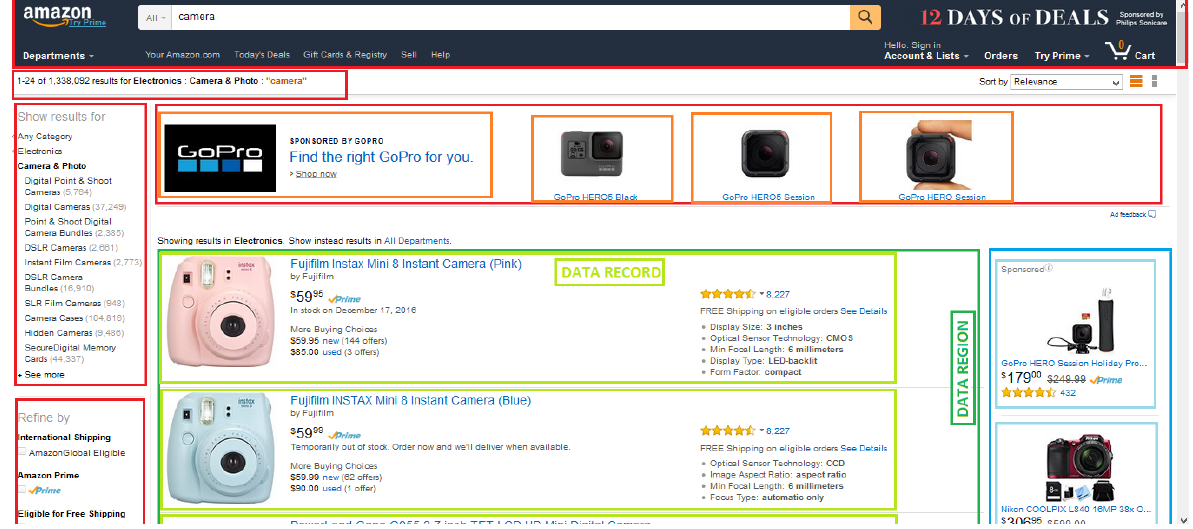
Figure 1. A sample results page of a website for